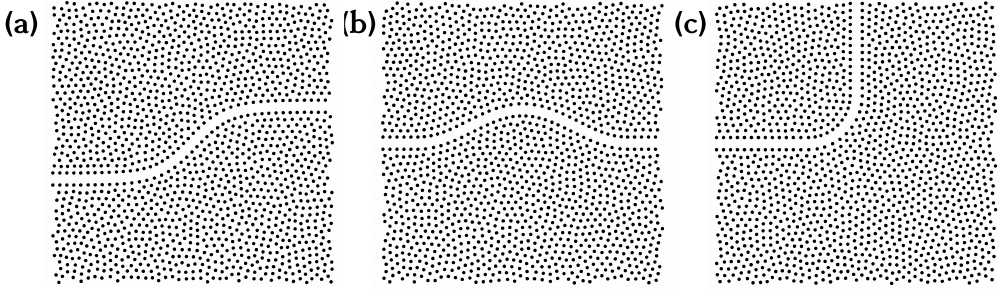
Figure 4. ( a ) A hyperbolic tangent-shaped waveguide; ( b ) a cosine-shaped waveguide; and ( c ) a 90 ◦ -bend waveguide.